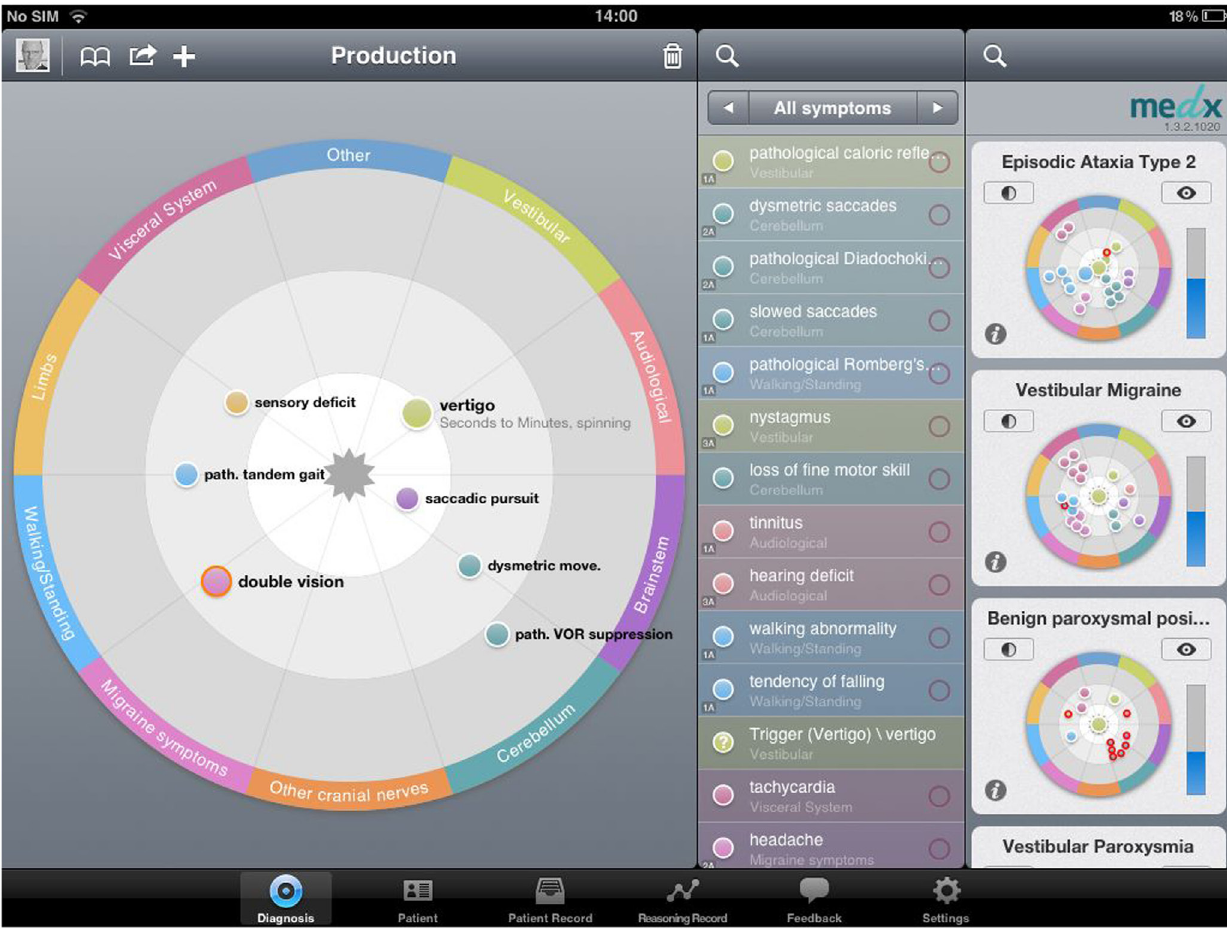
FigUre 1 | me d x iPad surface. Production of a diagnosis in constellatory diagnostic system, putting information of patient’s history. During the diagnostic process, the user has various choices, starting with patient history and symptoms, but other sources of information (clinical examination, diagnostic procedures) can be included as well (“all symptoms”). As this input is provided, the system, in parallel, already starts to seek and prioritize the best-matching patterns of symptoms (right part of the picture, diagnoses listed by probability). This process does not compare lists or maps of features, but it allows for the mutual unfolding of the meaning of all involved symptoms. The user can sort and differentiate the entered information according to the subjective (or objective) relevance; the closer the user “swipes” it to the center of the diagnostic field (on the left side of the picture), the higher this information is included in the calculation of the system. The more information you can add to the program, the higher the accuracy of the proposed diagnoses of the